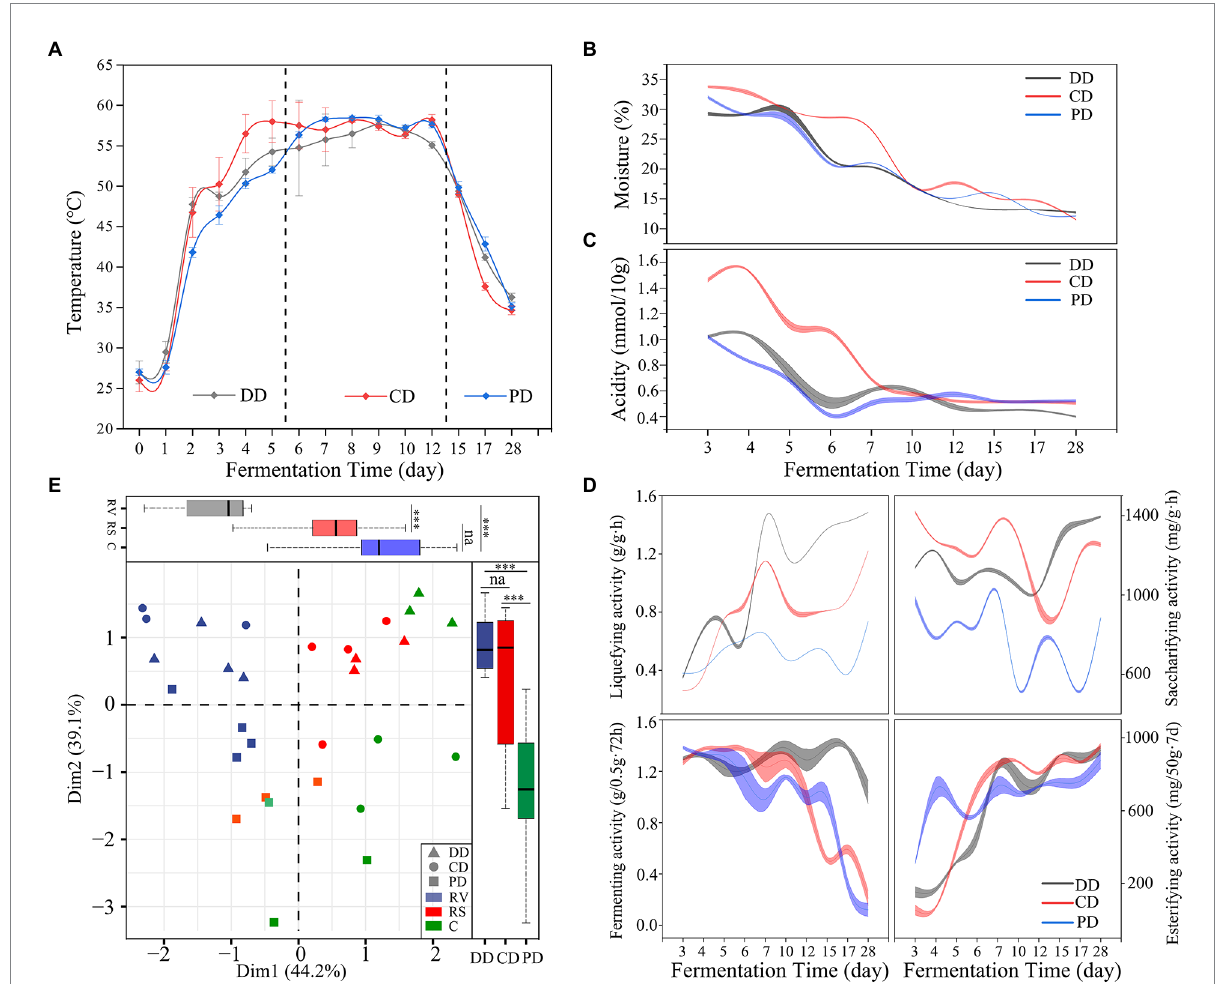
FIGURE 2 Fermentation parameters and enzymatic activity during the fermentation process. (A–D) The dynamics of fermentation parameters and enzymatic activity. (E) The phase (RV, days 0–6; RS, days 7–12; C, days 13–28) and type division according to principal component analysis based on the Bray–Curtis dissimilarity matrix of enzymatic activity (one-way ANOVA, *** p <